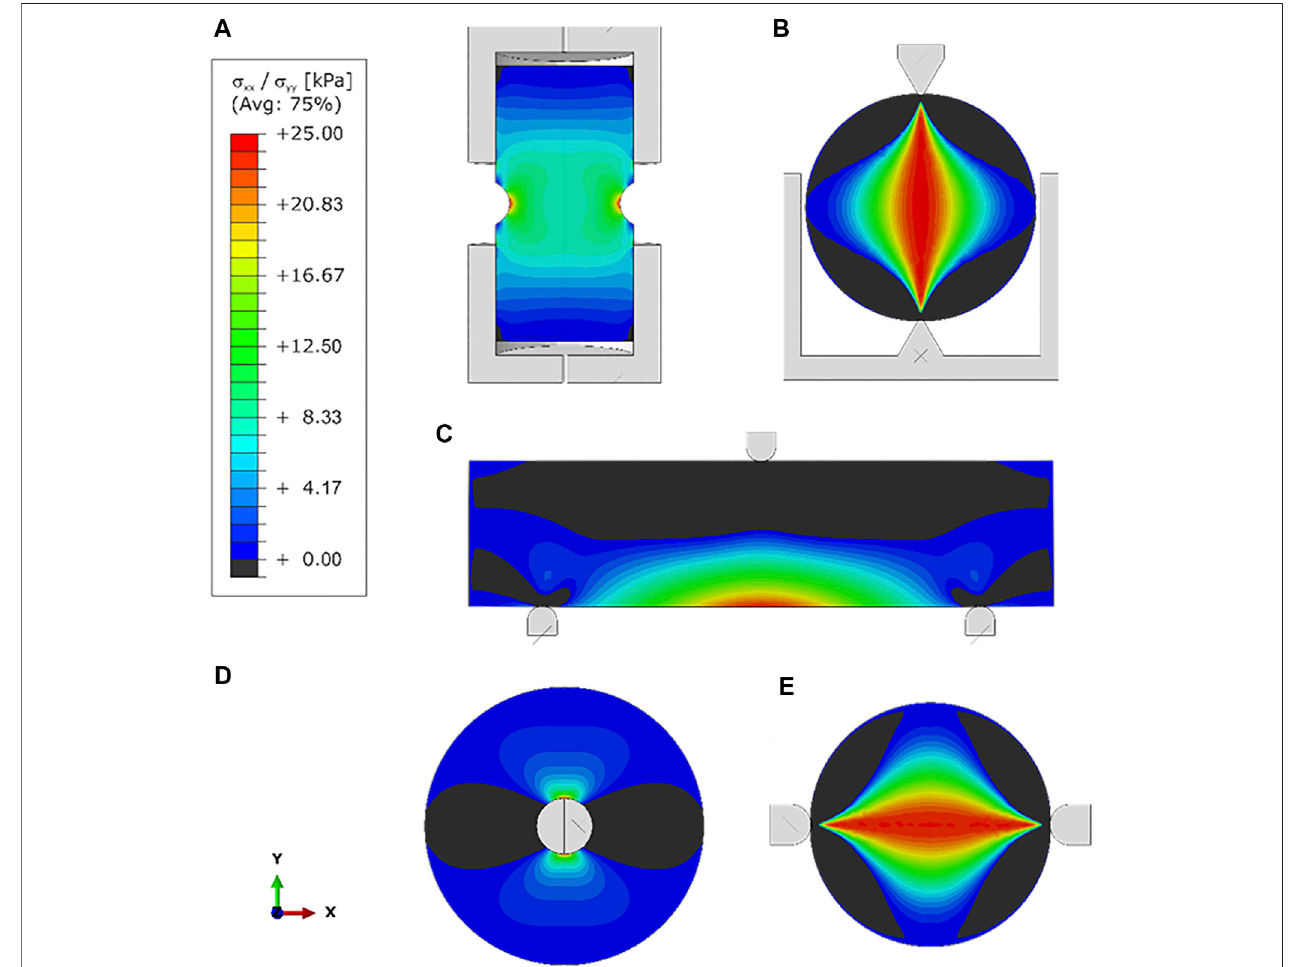
FIGURE 11 | Stress distribution of samples in different test methods (A) UDTT, (B) BT, (C) TPBT, (D) IHFT, and (E) HCT.